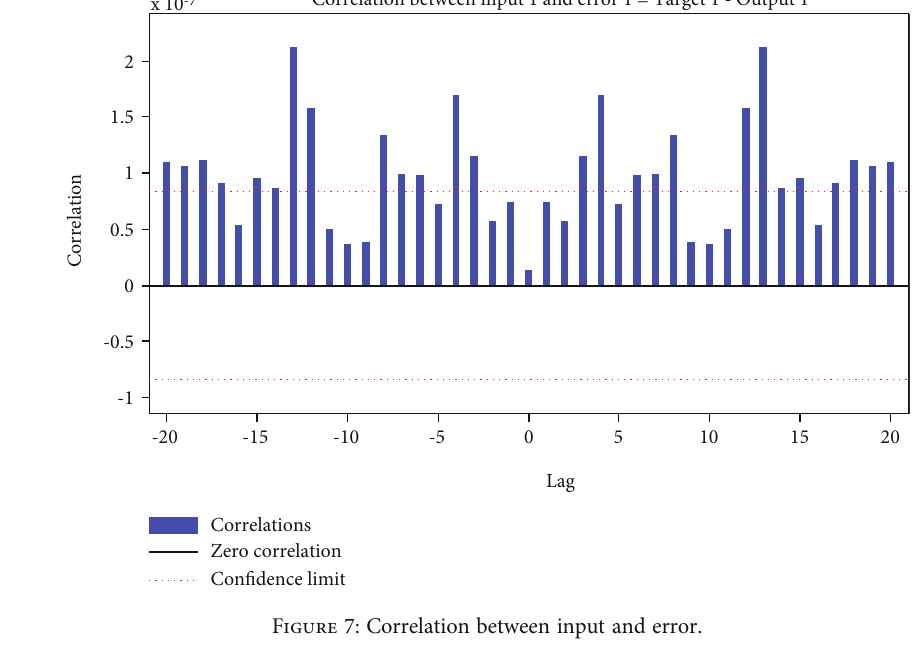
Figure 7: Correlation between input and error.